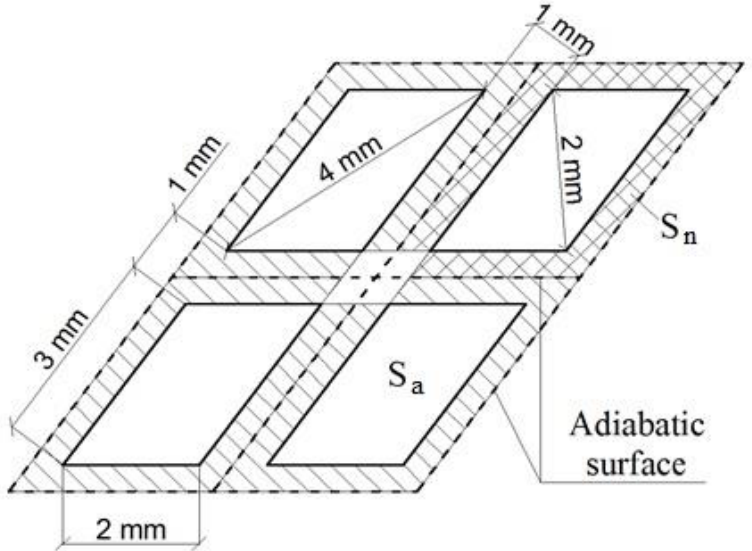
Figure 2. Cross-section of the four adjacent nozzle channels: S n and S a are the nozzle and air passage cross-sectional areas.